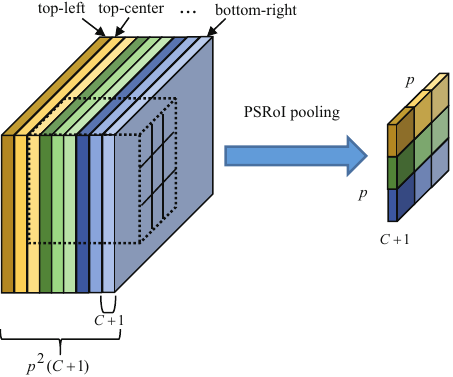
Figure 8. The architecture of position-sensitive region of interest